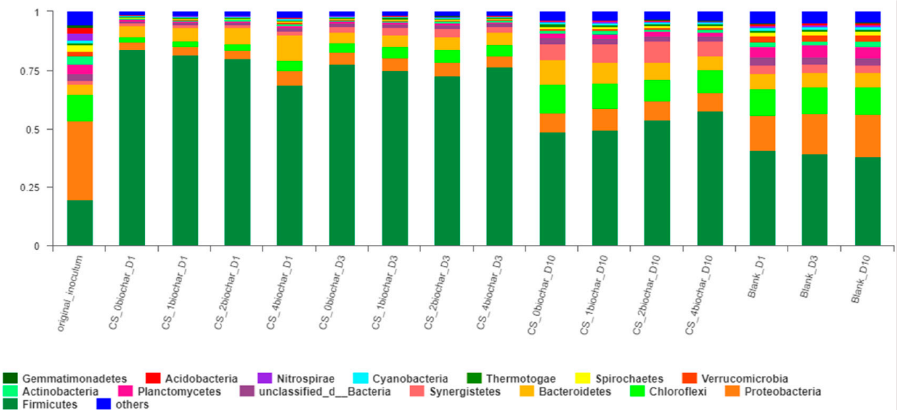
Figure 3. Taxonomic distribution of bacteria at phylum level.